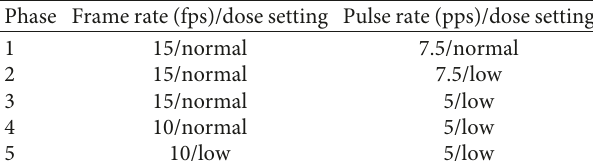
Table 1: Selected frame rate and pulse rate settings during the different phases of this